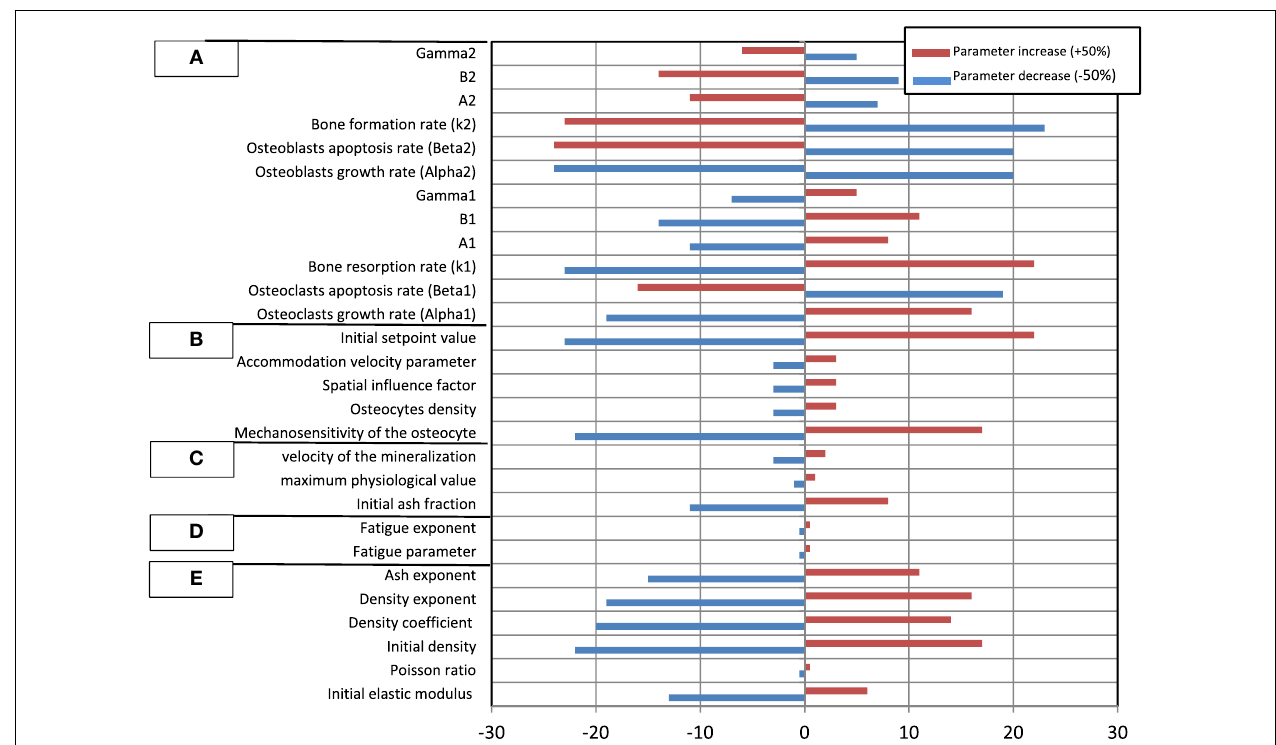
FIGURE 6 | Relative percentage change of the predicted bone density in the femur neck . Model parameters were varied between − 50 and + 50%. (A) Osteoblasts and osteoclasts factors, (B) transduction factors, (C) mineralization factors, (D) fatigue damage factors, (E) general (mechanical)